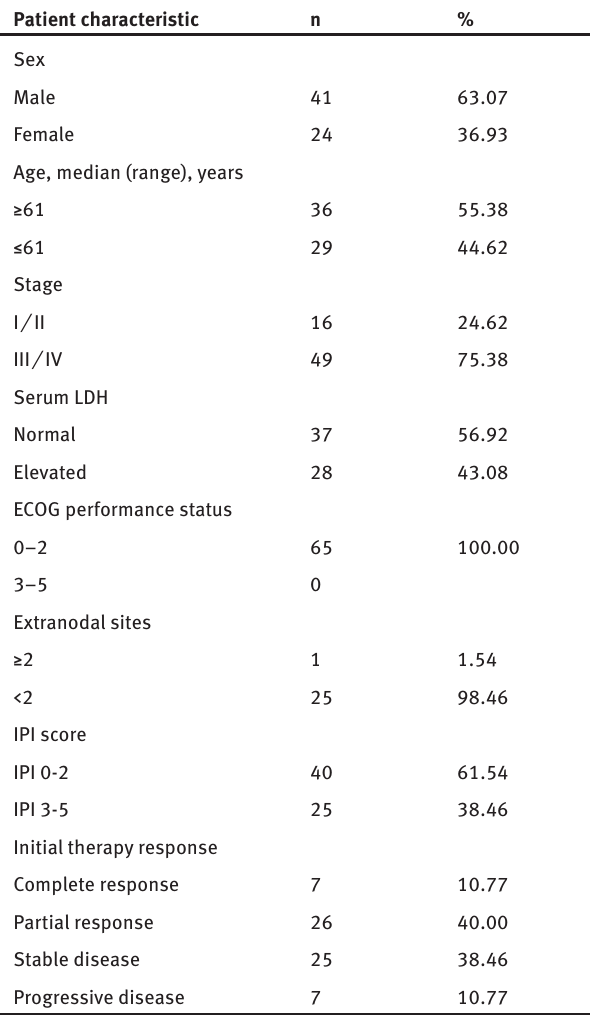
Table 1: Characteristics of patients with diffuse large B-cell lym- phoma (n = 65)